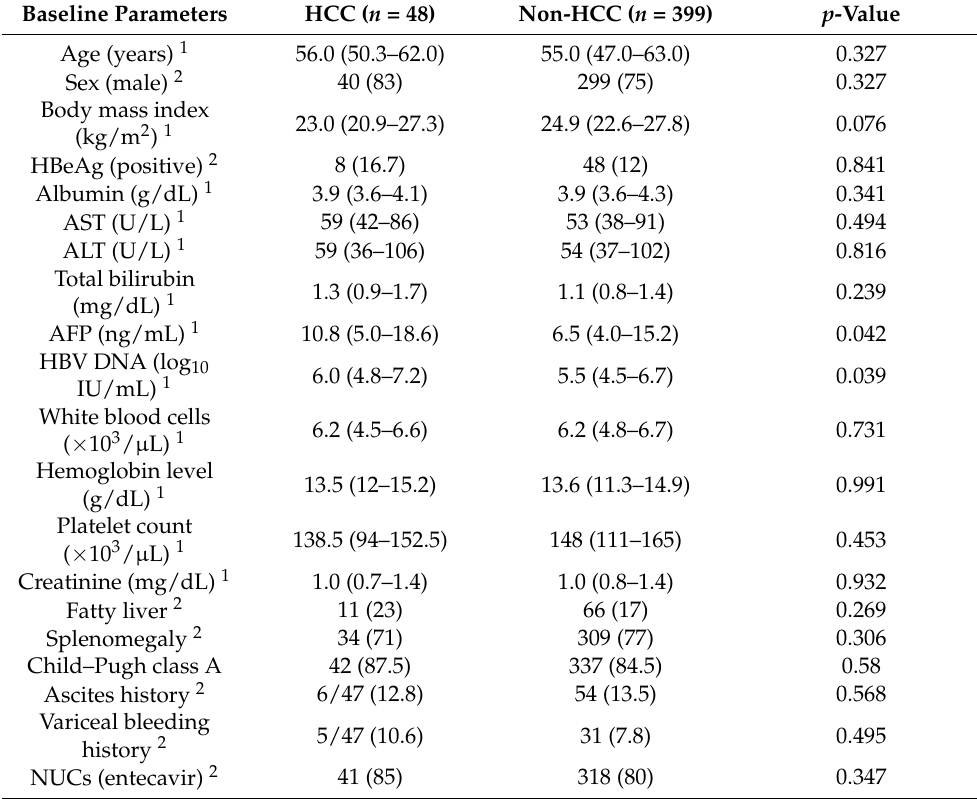
Table 1. Baseline characteristics of cirrhotic chronic hepatitis B patients with and without hepatocel- lular